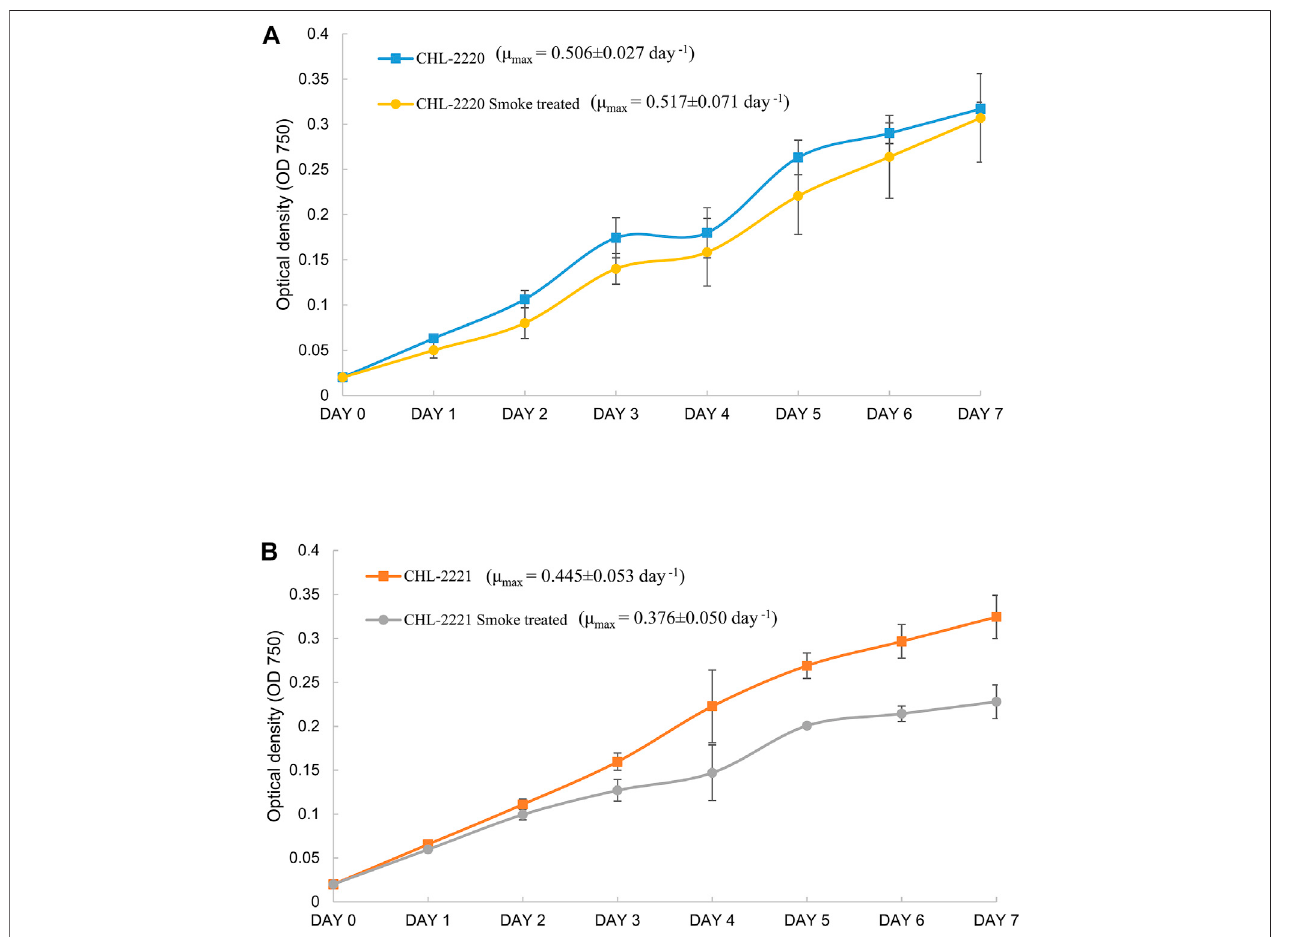
FIGURE 1 | Comparison of growth of CHL-2220 (A) and CHL-2221 (B) grown under tobacco exposure and ambient conditions. Data signify the mean value of triplicates and error bars are standard deviations.